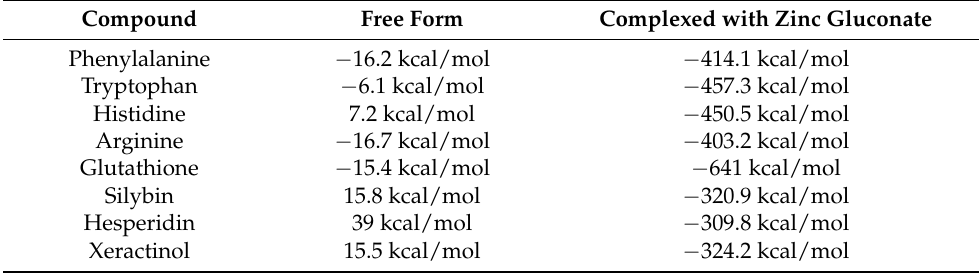
Table 3. Molecular mechanics computed energy E of free forms of natural compounds, such as amino acids, glutathione and polyphenols and when forming complexes with zinc gluconate. Compound Free Form Complexed with Zinc Gluconate